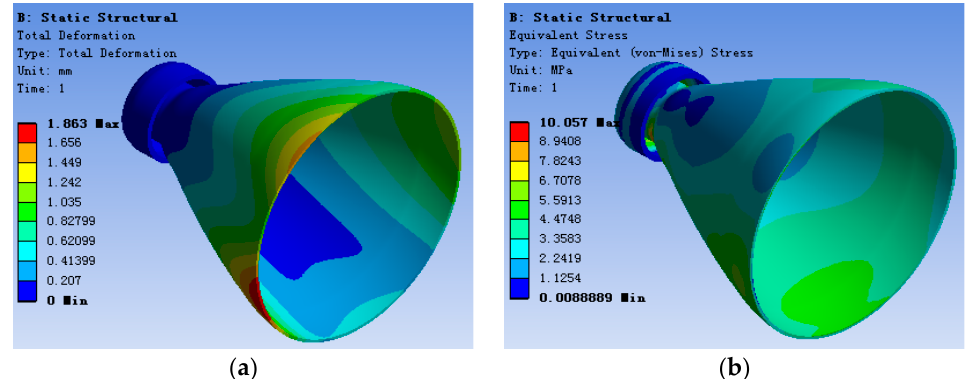
Figure 23. Cloud map of ground nozzle properties. (Ground, 3 MPa.) ( a ) Structure Deformation. ( b ) Stress Distribution.